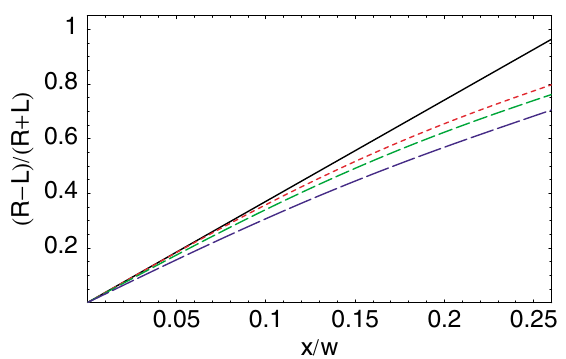
FIG. 9. (Color) Relative magnitude of beam-size corrections in =w (cid:3) 0 : 1 , (cid:7) =h (cid:3) 0 : 05 for three a square chamber with (cid:7) x y vertical beam offsets y=h (cid:3) 0 ; 1 = 8 ; 1 = 4 (short-dashed, dashed, long-dashed lines). Here 1 corresponds to a pencil beam case, i.e., to one of the three curves in Fig. 6 for the corresponding (cid:3) (cid:7) (cid:3) 0 ). x y beam vertical